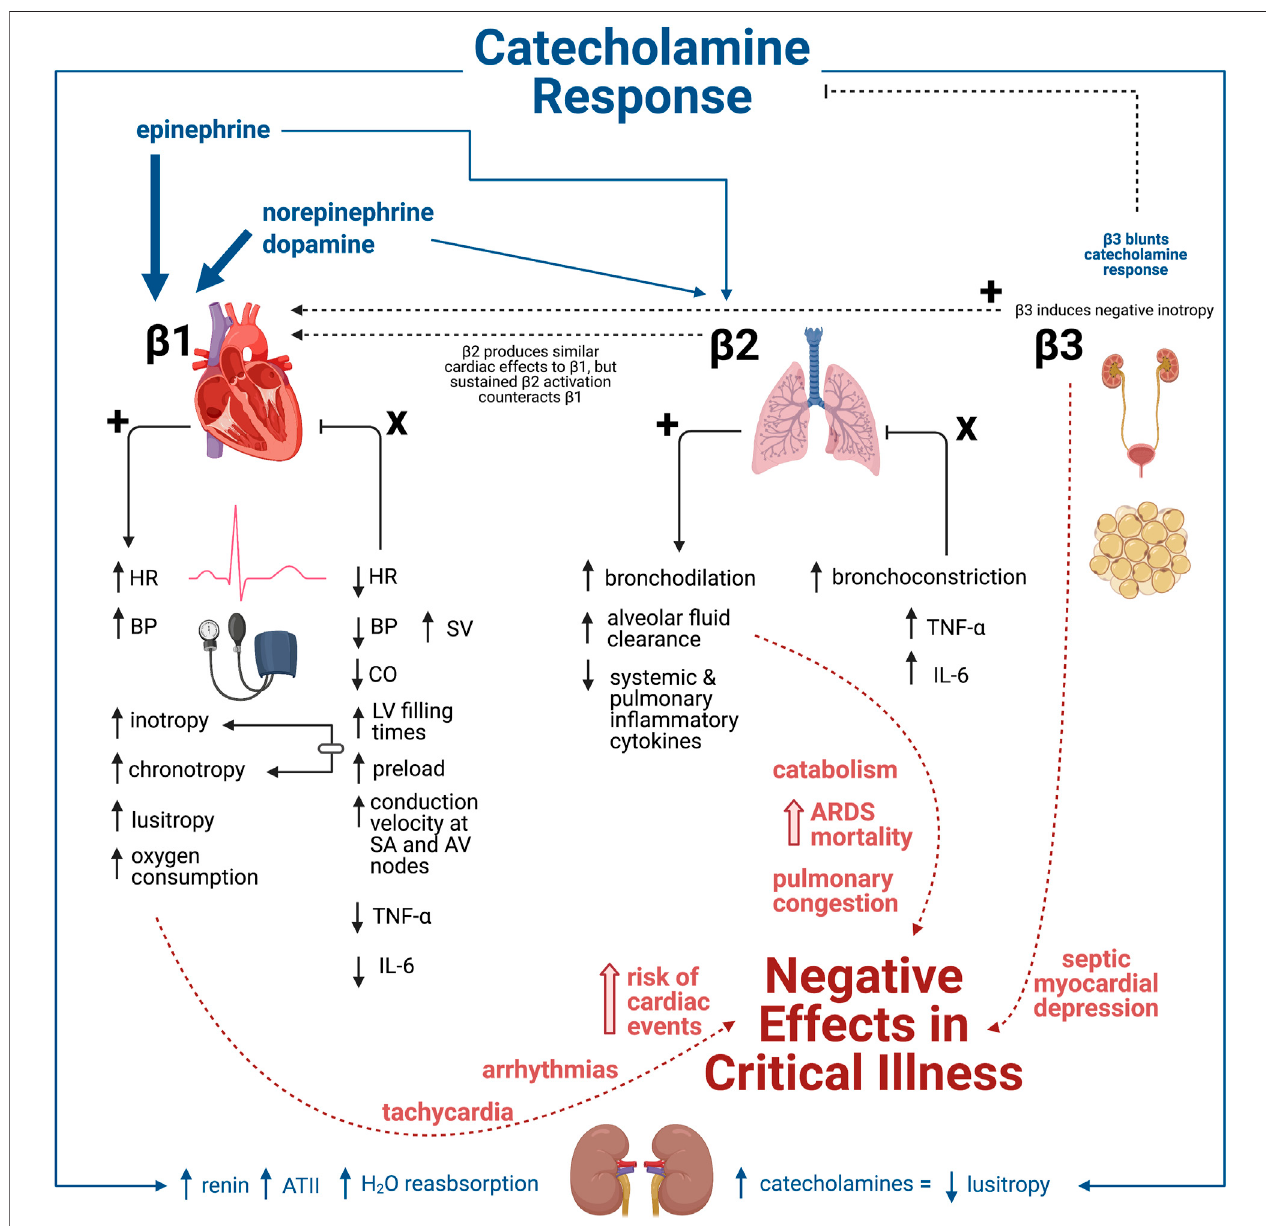
FIGURE 1 | Physiologic response to β -adrenergic receptor agonism and antagonism in critical illness. The catecholamine response characterized by epinephrine, norepinephrine, and dopamine release result in stimulation of β 1 (majorly) and β 2 (minorly). In contrast, β 3 agonism blunts the catecholamine response. The physiologic response to β 1, β 2, and β 3 agonism culminates in numerous negative effects within critical illness that can ultimately lead to negative clinical outcomes including increased mortality. This introduces the bene fi cial physiologic response of β B antagonism as a way to mediate the detrimental effects of the hyperadrenergic state prominent in various types of critical illness. Illustration created with